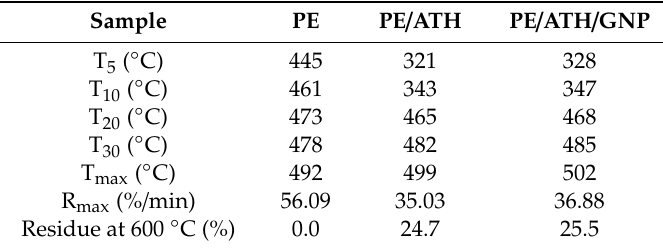
Figure 5. ( a ) TG curves of PE, PE/ATH and PE/ATH/GNP; ( b ) TG weight difference between PE/ATH/GNP and PE/ATH. Table 2. TG data of PE / ATH and PE / ATH /